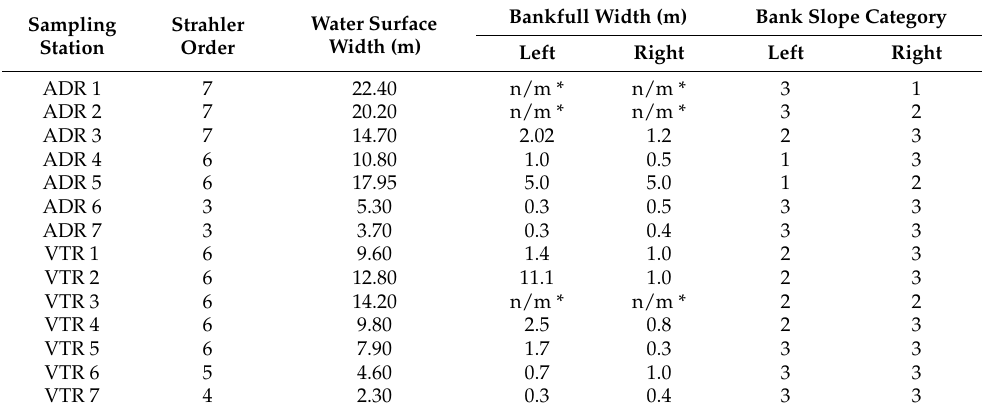
Table 3. Water surface width (WSW) and bankfull width (BW) values and the stream bank slope